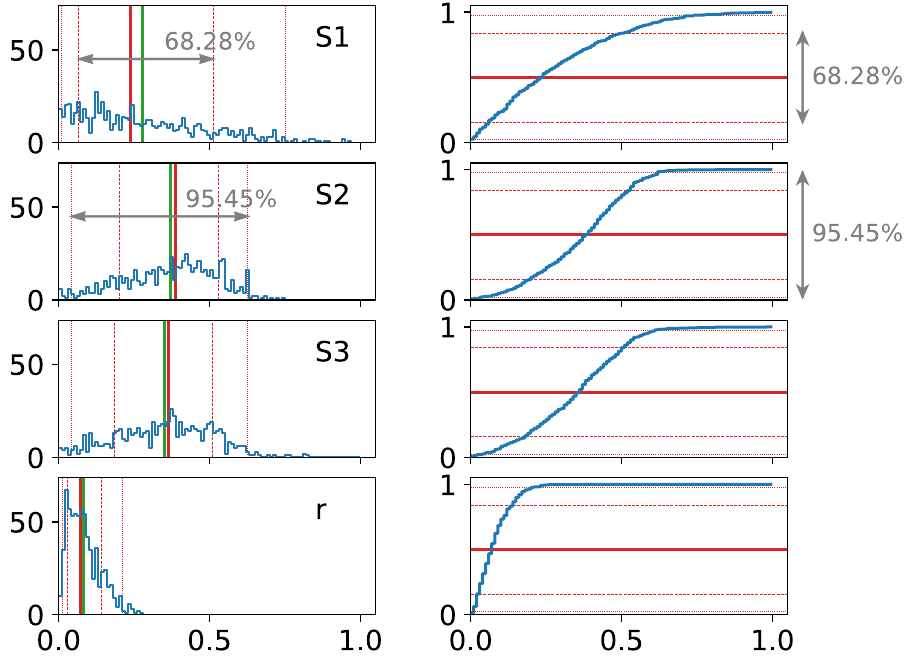
Fig 9. Example calculation of statistical uncertainty based on the simulation described in Sec. 3.3. The cumulants of evaluated variables are used to determine the boundaries of 68.28% (“1 σ ”, dashed red lines) and 95.45% (“2 σ ”, dotted red lines) confidence intervals. Solid green and red lines stand for mean and median,